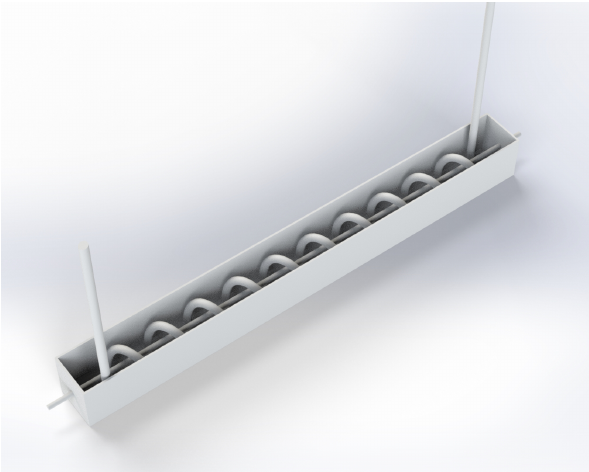
Figure 2. Photograph of one of test sections.